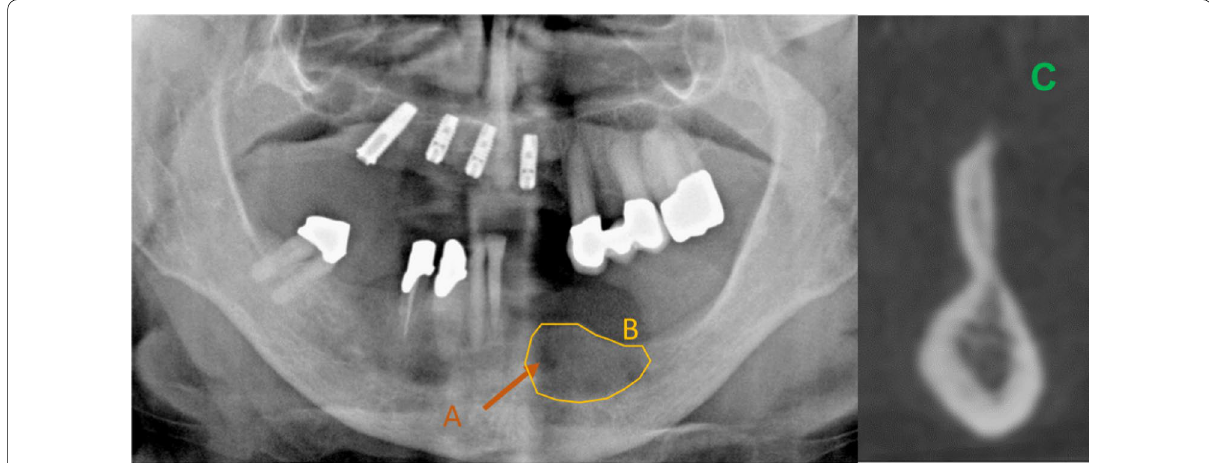
Fig. 4 Panoramic radiography image showing A a distinct hypodense lesion and B a translucent area. The depiction of the same region in CBCT